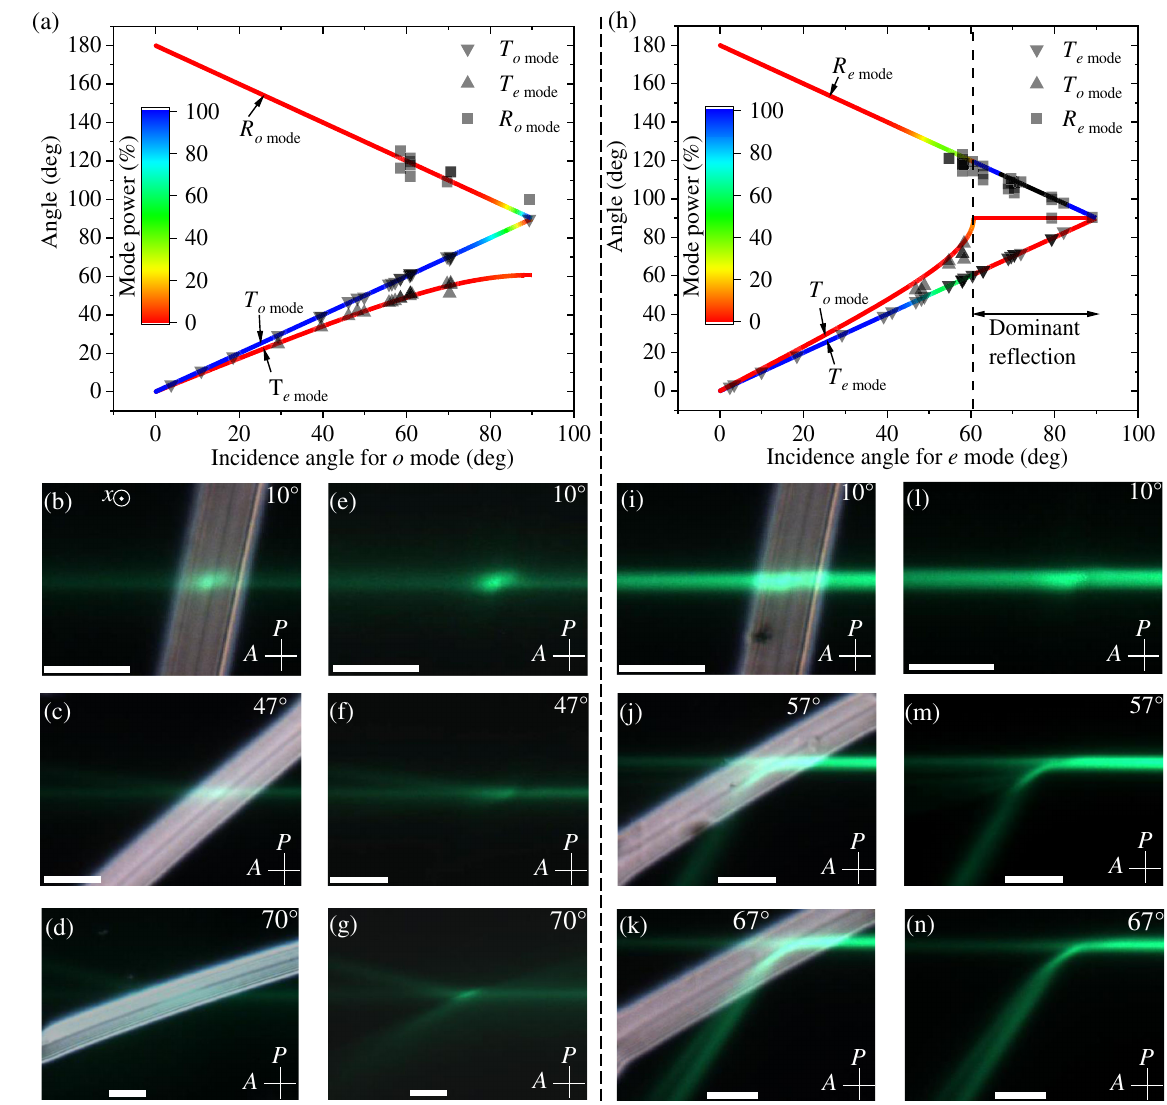
FIG. 5. Comparison of our modification of Snell ’ s law to experiments with an ordinary (left) or extraordinary (right) polarized beam impinging on a CF3. Angles of transmission and reflection are shown for an o -mode incident beam in (a) or an e -mode incident beam in (h). Predicted reflection ( R modes) and transmission ( T modes) modes are indicated by the colored solid lines. Relative mode power o;e o;e as a function of the incidence angle is depicted by the color scale as shown. Experimental data, at incidence angles with nonzero mode powers, verify the trajectories predicted by our generalization of Snell ’ s law. POM images of an incident o -mode (b) – (g) or e -mode (i) – (n) beam interacting with a CF3 are shown below (a),(h). The beam propagates from right to left in each micrograph. In (b) – (d) and (i) – (k), the sample is illuminated with a backlight to view the birefringent medium ’ s soliton. In (e) – (g) and (l) – (n), the backlight is extinguished to capture the beam ’ s optical interaction with the soliton. Each interaction, as indicated by the incidence angles as shown, is portrayed as a pair of POM images viewed with and without a backlight. In general, as the incidence angle increases, different mode powers become nonzero as shown with a transition from total transmission to a regime with weak transmission and dominant reflection in (h). The scale bar ’ s length is 100 μ